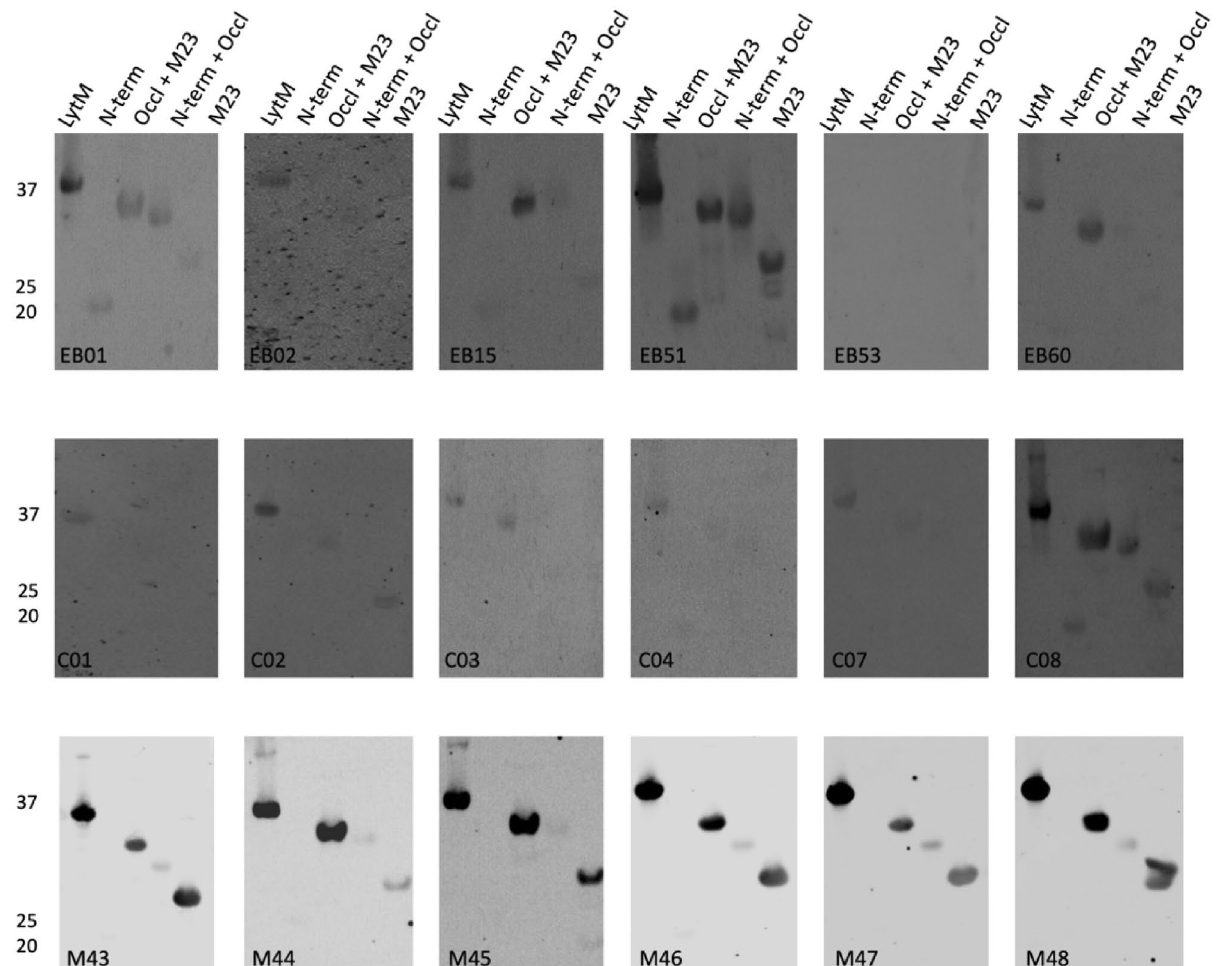
Figure 8. Specific binding of IgGs from EB patients, healthy volunteers and immunized mice to LytM and its N-terminal, occluding and M23 domains. The purified full-size LytM protein, and its N-terminal, occluding plus M23, N-terminal plus occluding, and M23 domains were separated by LSD-PAGE and analyzed by Western blotting using sera from EB patients (top panels), healthy volunteers (middle panels) and mice immunized with LytM (bottom panels). The respective sera used for Western blotting are indicated in each panel. The molecular weights of LytM and its domains are indicated on the left (in kDa). For original Western blots see Supplemental Fig. 2F. The Western blotting experiments were replicated